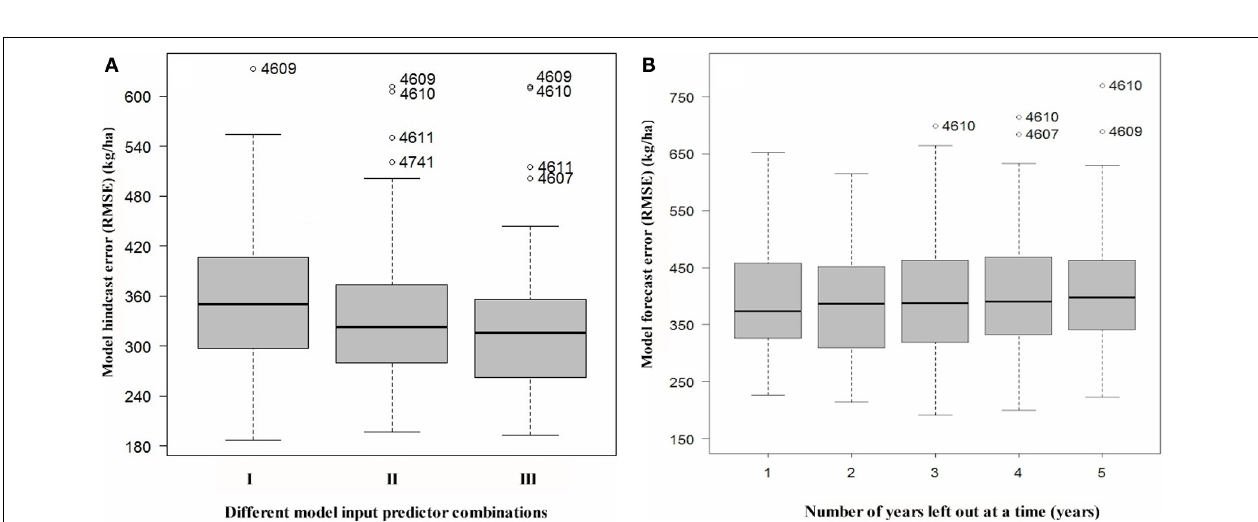
FIGURE 10 | (A) Variation in model hindcast/backcast error from leave-one-out cross-validation (LOOCV) (RMSE in kg/ha) for three different combinations of input predictors: (I) Agro-climate indices (WDI, GDD, SWA), (II) Remote-sensing index (NDVI), and (III) Agroclimate and NDVI index (WDI, GDD, SWA, NDVI). A year effect is included in all cases. For case (III), the CAR 4610 is an outlier (as per the 2012 model forecast output results shown in Figure 5 ). Unlike the single year model forecast results for 2012, the